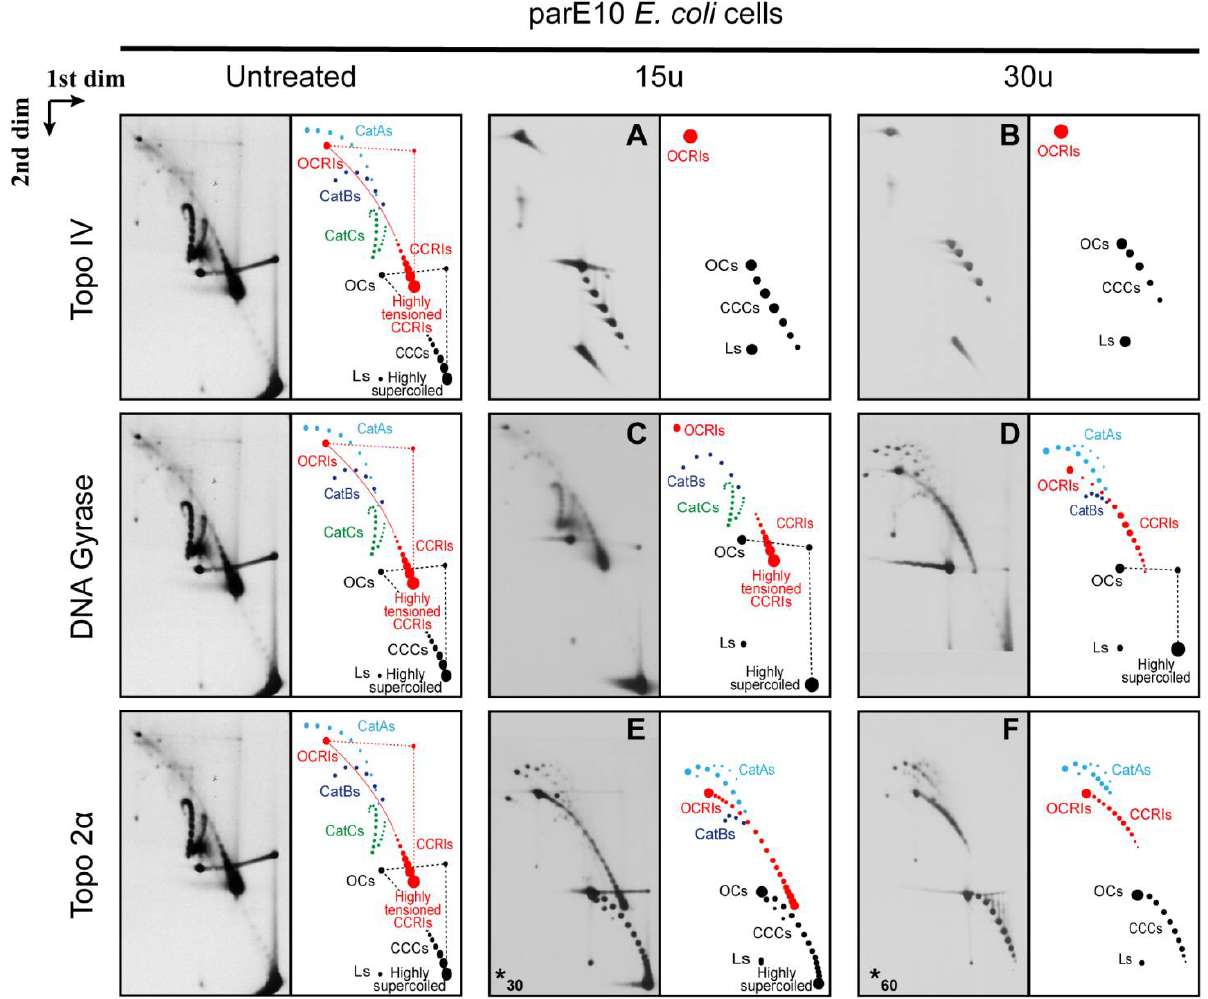
Figure 5. Immunograms and interpretative cartoons of intact untreated and treated forms of pBR- TerE@ AatII isolated from parE10 E. coli cells where the last at 60 min occurred at the restrictive temperature (43 °C). All the samples were analyzed by two-dimensional agarose gel electrophoresis. The immunograms to the left correspond to the untreated sample and were only placed for comparison. Samples were treated with 15 units ( A , C ) or 30 units ( B , D ) of the topoisomerases in vitro, as indicated in Material and Methods, except for topo 2 α , where 60 units ( E ) and 240 units ( F ) were used (indicated by an asterisk at the left down corner). CCCs and OCs are indicated in black. Dashed straight lines indicate smears of the most abundant species that occur during the first and second electrophoresis. CCRIs and OCRIs are depicted in red. Where it applies, fully replicated catenanes (CatAs, CatBs and CatCs) are depicted in light blue, dark blue and green, respectively. The position of highly supercoiled and highly tensioned CCRIs is indicated. The immunograms on top correspond to samples treated with Topo IV; below are the immunograms that correspond to samples treated with DNA gyrase and at the bottom the immunograms correspond to samples treated with Topo 2 α as indicated in Material and Methods. * In this case a different number of units was used.